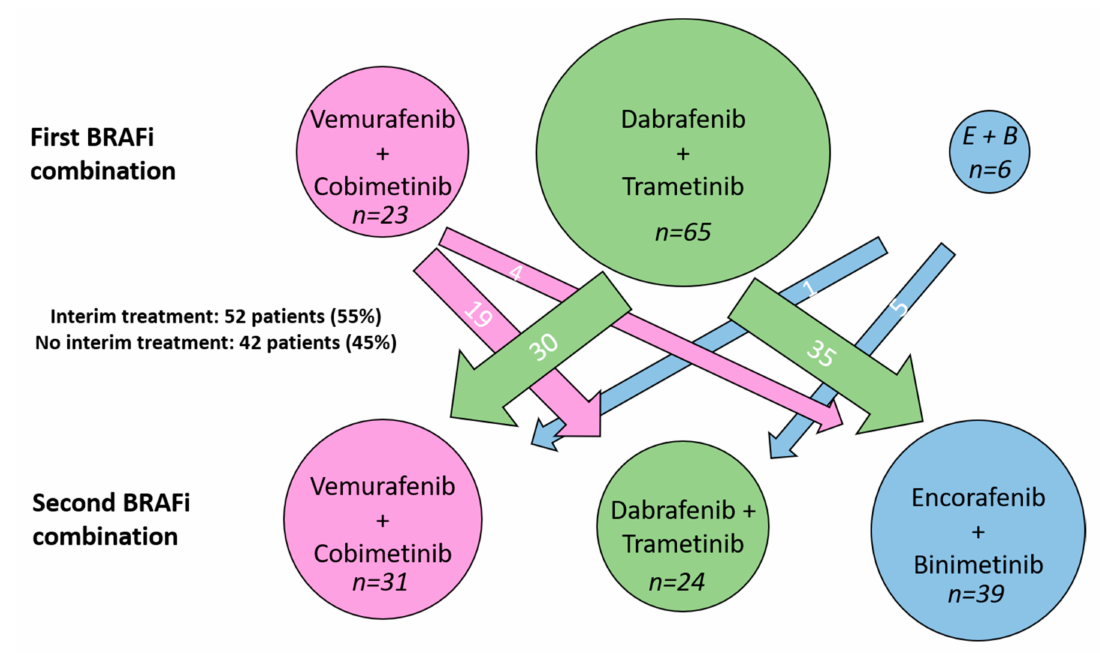
Figure 1. Number of patients treated with each BRAF+MEK inhibitor combination and the respective switch to the new combination treatment.